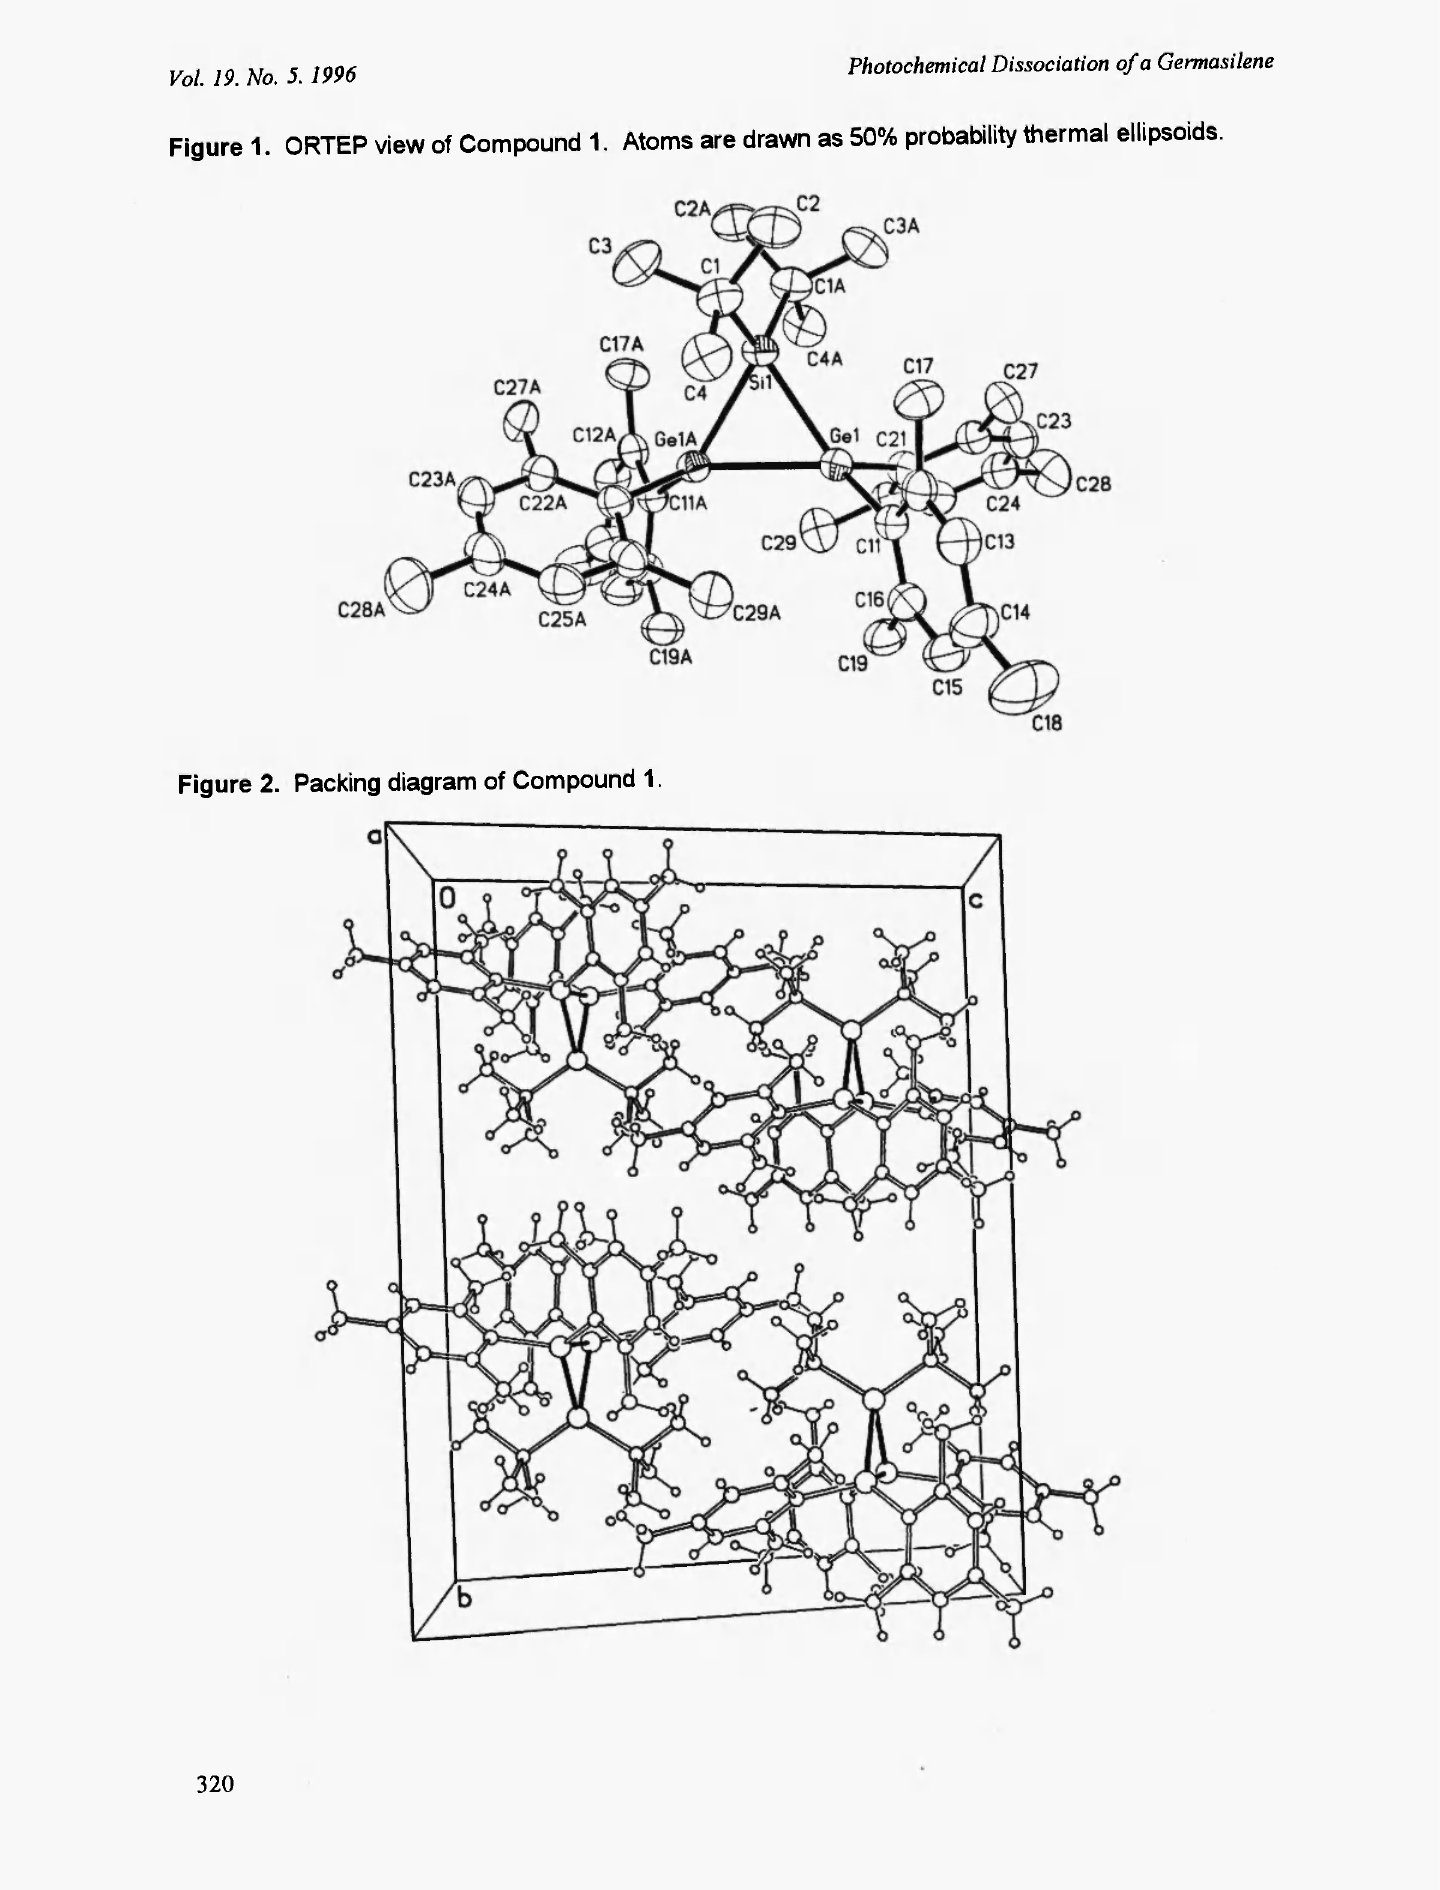
Figure 2. Packing diagram of Compound 1